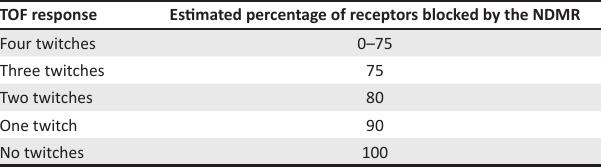
TABLE 1: Twitch response and percentage of the blockade. TOF response